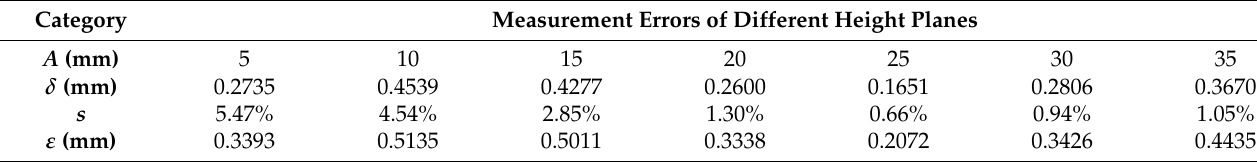
Table 1. Measurement errors of different height planes.